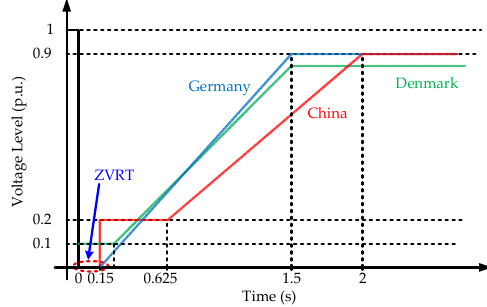
Figure 8. Low-voltage (and zero-voltage) ride-through requirements for grid-connected systems in different countries [15–17].